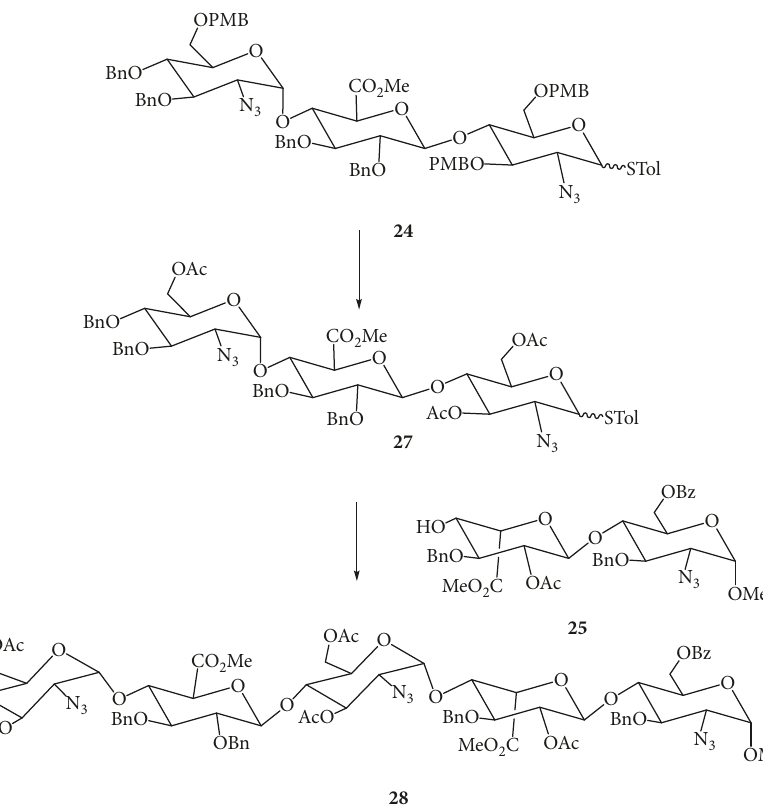
Scheme 7: Ding’s strategy for synthesis of protected pentasaccharide.